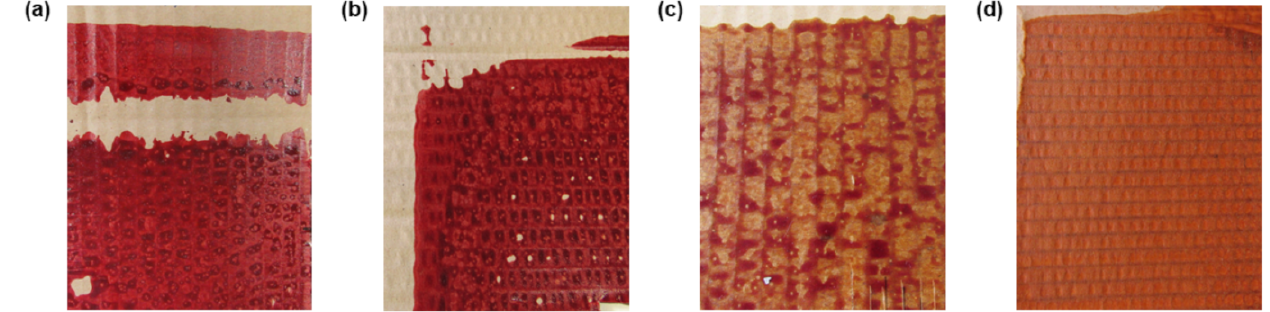
Figure 1. Cardboard samples after printing with pH-sensitive inks functionalized with ( a ) MR:MRs 1% ( w / v ), ( b ) MR:BB 1% ( w / v ), ( c ) MO:BP 1% ( w / v ), and ( d ) MO:BP 2% ( w / v